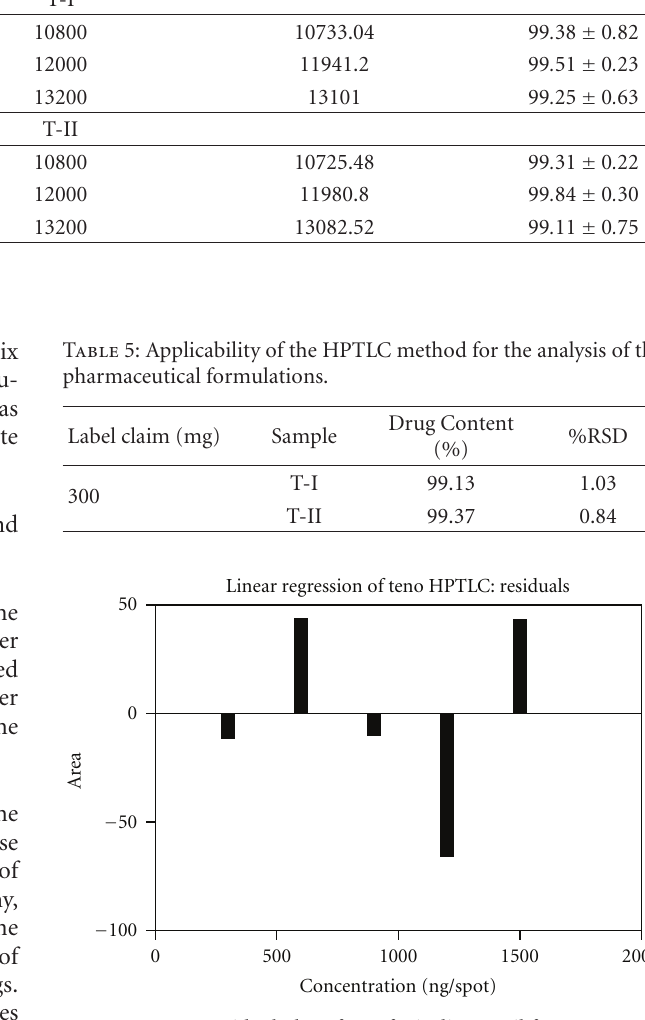
Figure 4: Residual plot of tenofovir disoproxil